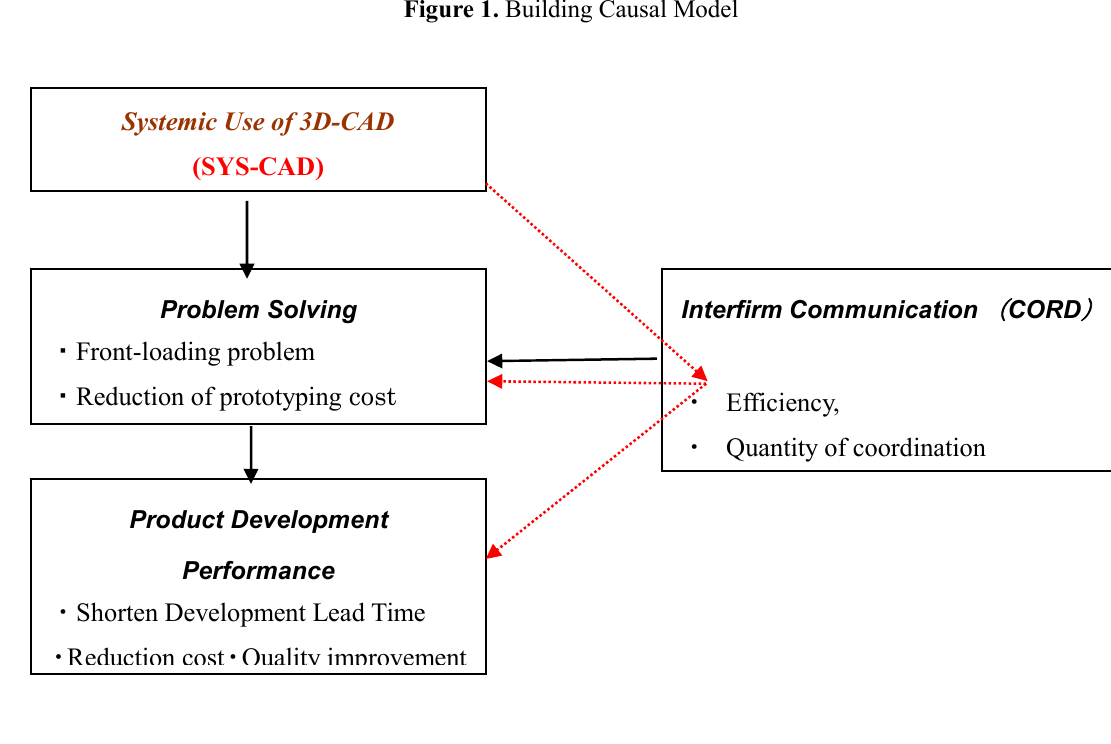
Figure 1. Building Causal